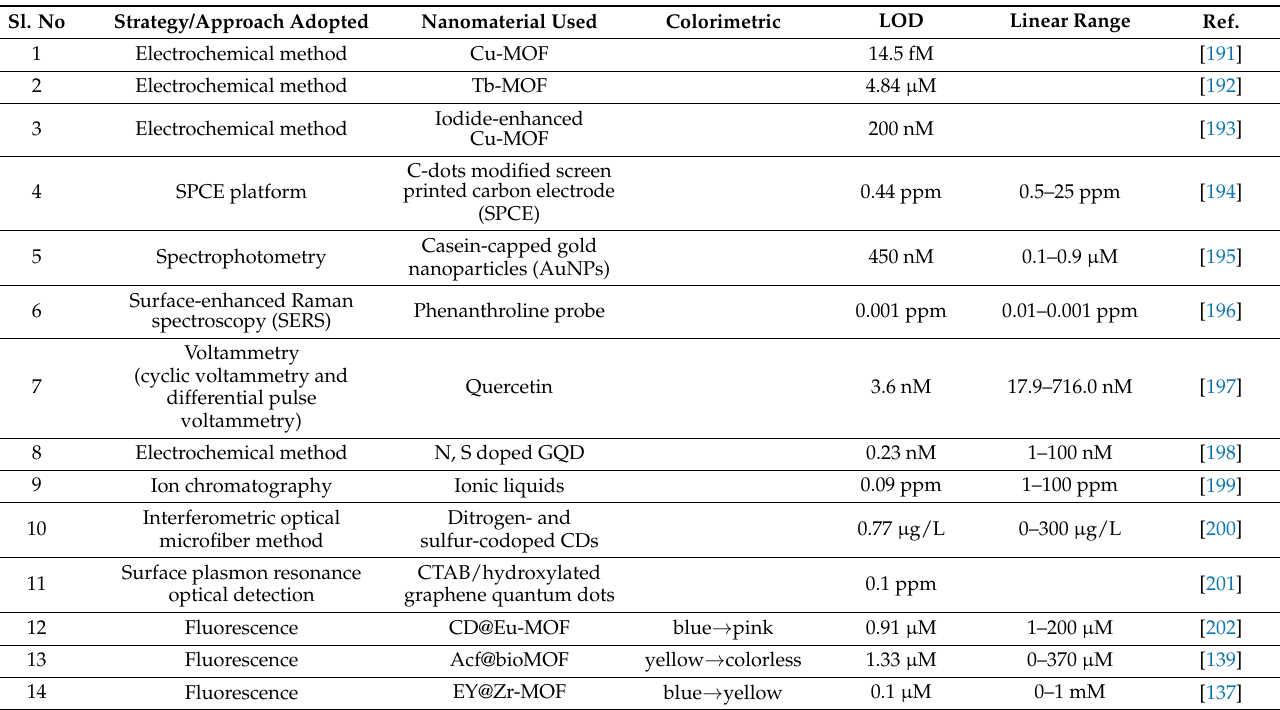
Table 3. Comparison of the performance of the techniques/strategies developed to detect Fe 3+ with the platform using fluorescence, presented along with their colorimetric method, limit of detection (LOD), and the linear sensing